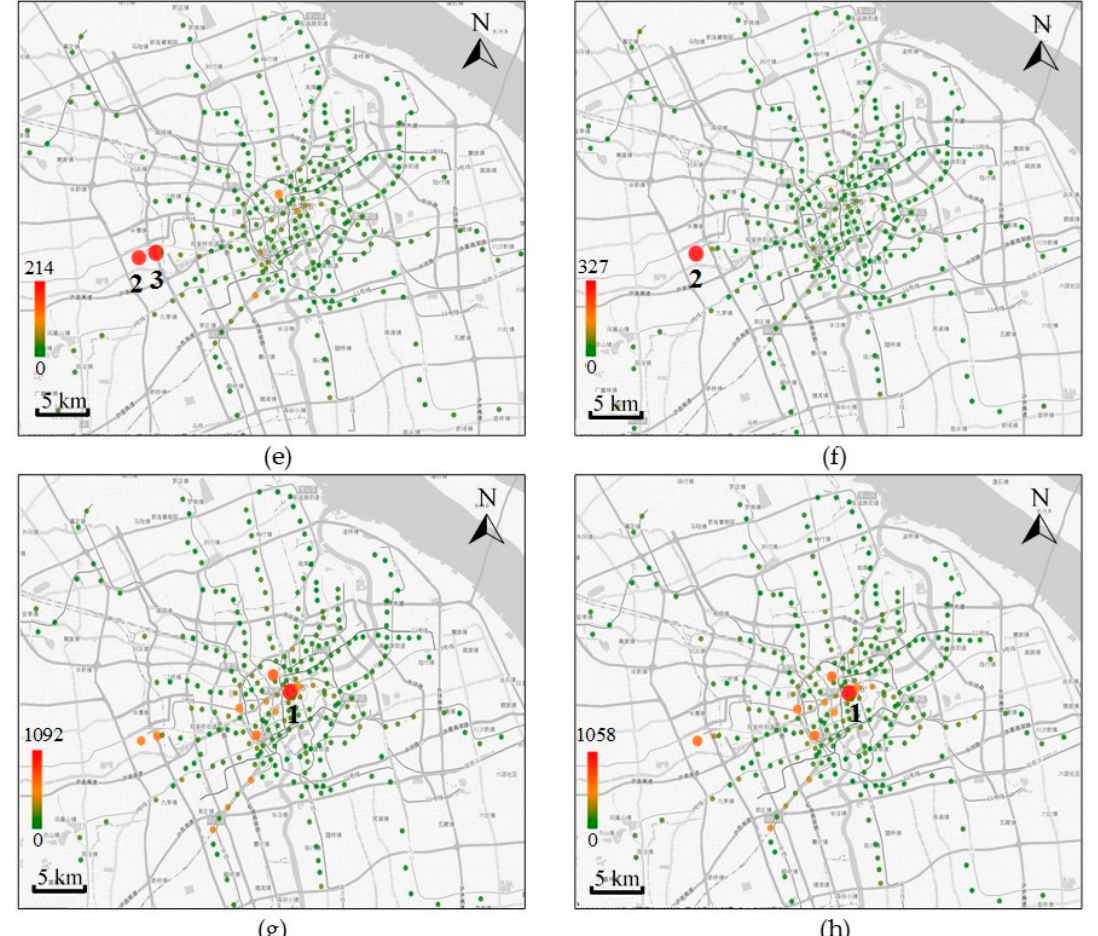
Figure 14. The spatial distribution of ( a ) the RMSE of passenger inflow volume, ( b ) the RMSE of passenger outflow volume, ( c ) the station mean actual value (SMAV) of passenger inflow volume, and ( d ) the SMAV of passenger outflow volume, at each metro station on working days; and the spatial distribution of ( e ) the RMSE of passenger inflow volume, ( f ) the RMSE of passenger outflow volume, ( g ) the SMAV of passenger inflow volume, and ( h ) the SMAV of passenger outflow volume, at each station on non-working days. The numbers 1–6 indicate the metro stations of People’s Square, Xu Jidong, Hongqiao Railway, Shanghai South Railway, Caohejing Development Zone, and Lu Jiazui, respectively.